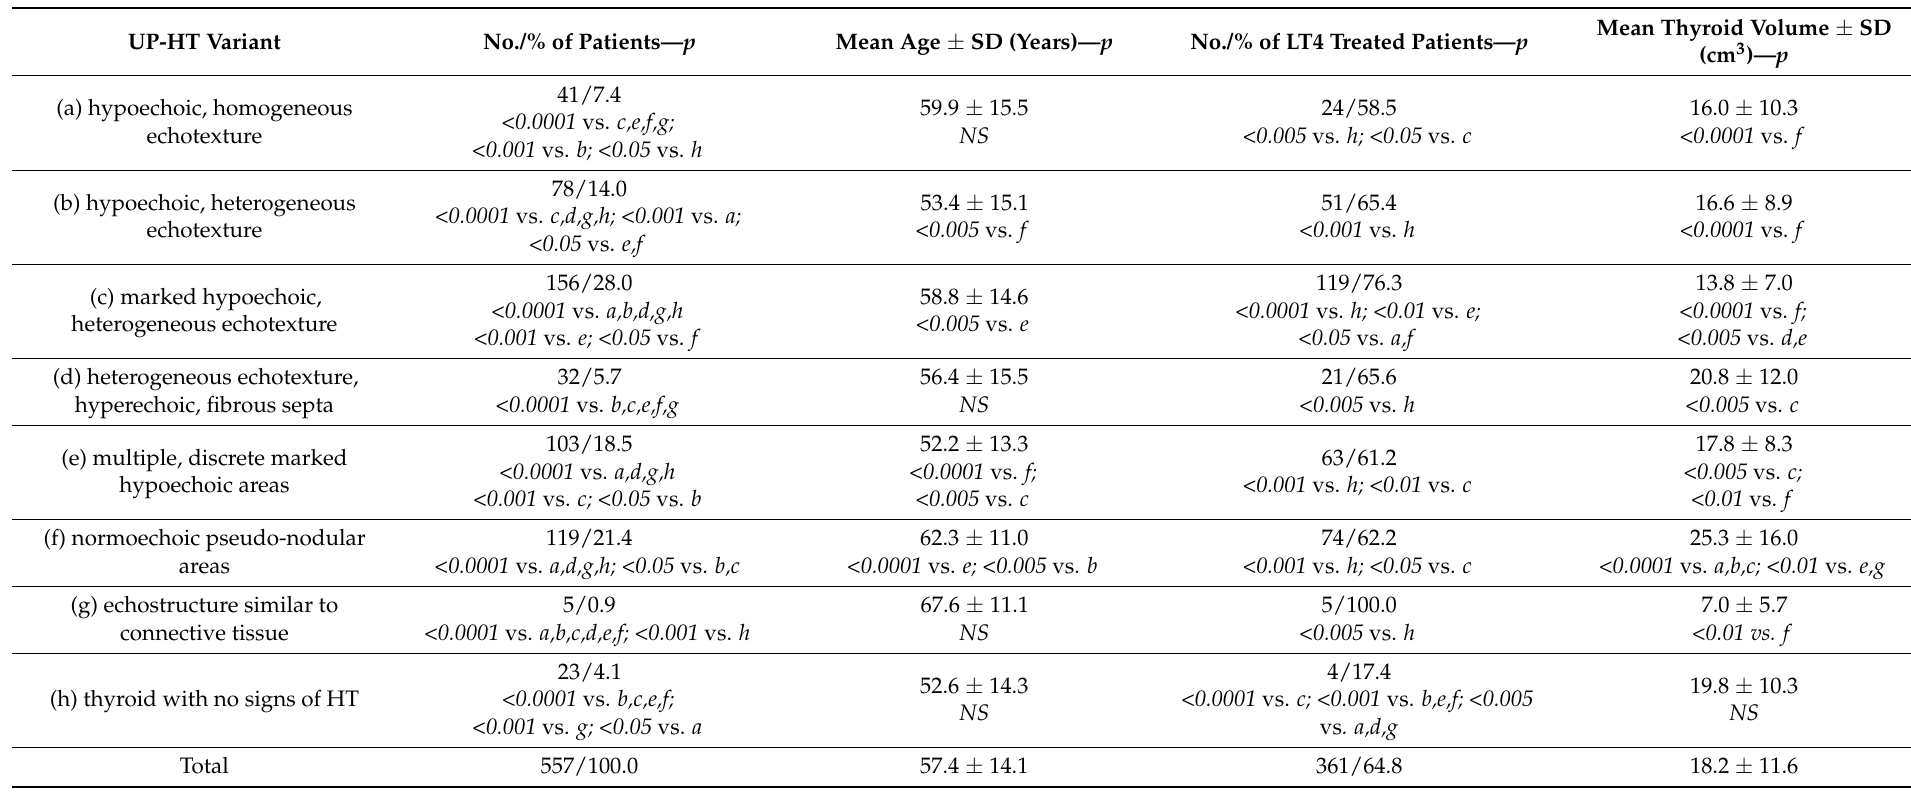
Table 1. Distribution of variants of ultrasonographic patterns of thyroid parenchyma in patients with Hashimoto (cid:48) s thyroiditis (UP-HT) subjected to the fine needle aspiration (FNA) of thyroid nodules, including demographic data, information on the treatment with levothyroxine (LT4), and thyroid